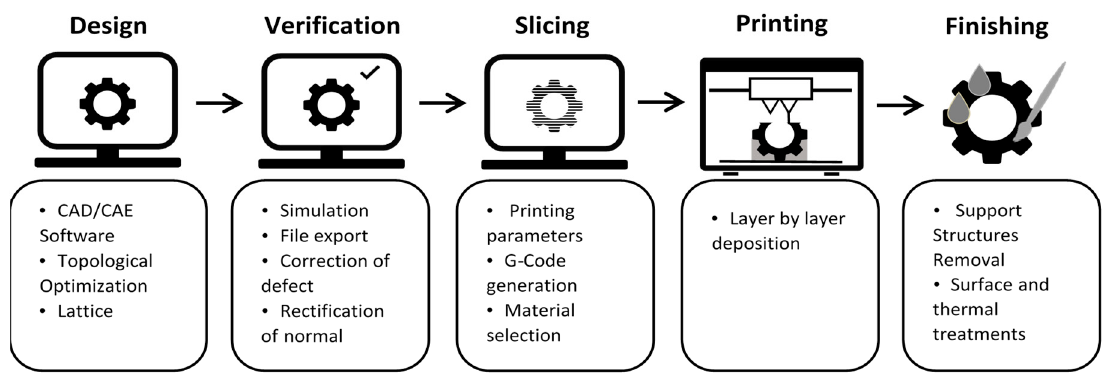
Figure 1. Additive manufacturing (AM) workflow. Note: CAD (Computer-Assisted Design); CAE (Computer-Aided-